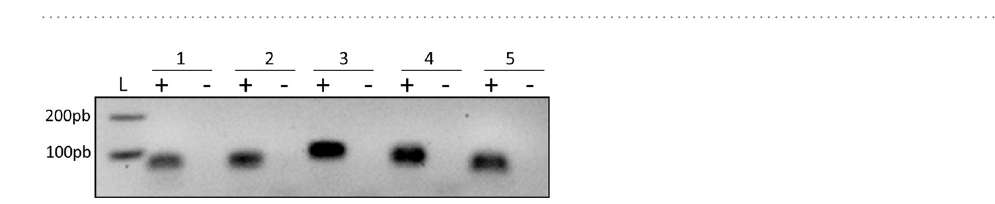
Table 3. Transcription detected on the opposite strand of the novel RNA transcripts determined by RNA-Seq. * The coordinates were determined using Artemis.